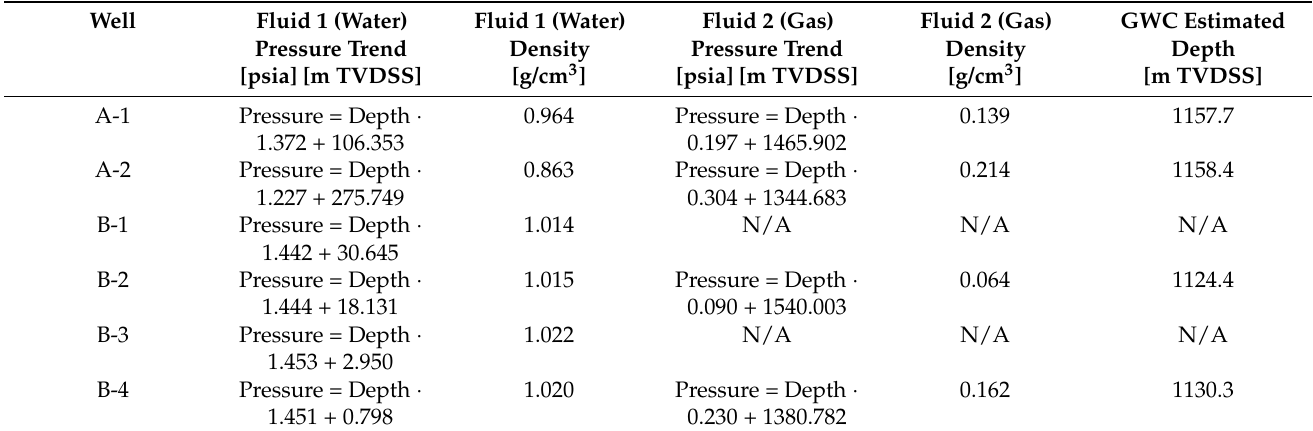
Table 5. Results of wireline formation pressure data processing and interpretation: pressure–depth gradients, fluid densities, and GWC depths estimated from the gradients’ slope and